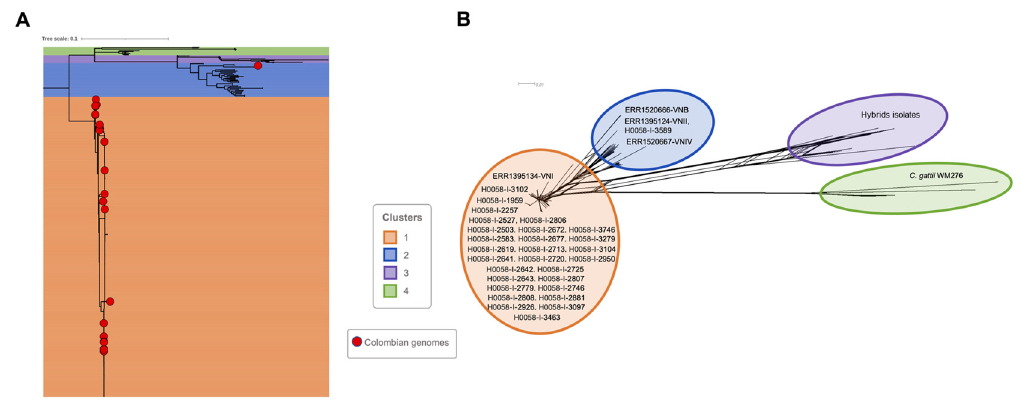
Figure 1. Phylogenetic relationship among the Cryptococcus genomes. ( A ) The figure represents the phylogenomic inference based on whole genome SNP alignments for the 611 genomic sequences analyzed in this study. The red dots represent the 29 Colombian genomes. ( B ) Phylogenetic networks constructed in SplitsTree 5, based on SNP alignments for 611 genomes analyzed. C. neoformans strain H99 was used as the reference genome, and C. gattii WM276 as an outgroup.